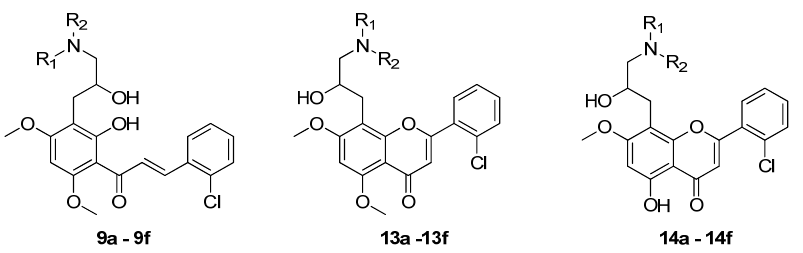
Figure 2. Structures of synthesized compounds 9 , 13 and 14